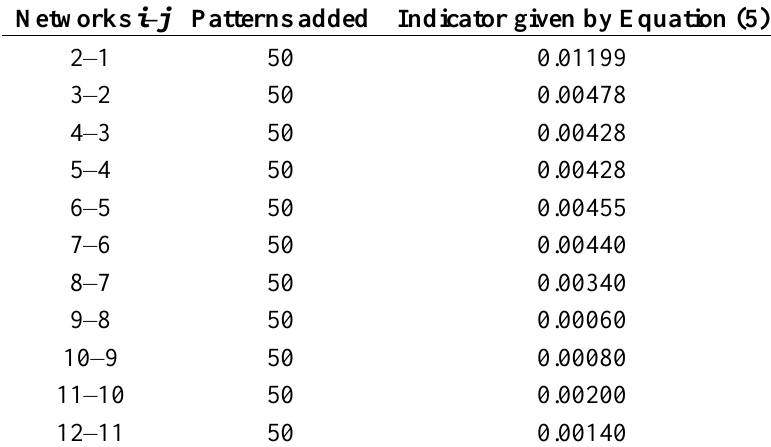
Table 4. Error variation between networks with respect to the number of